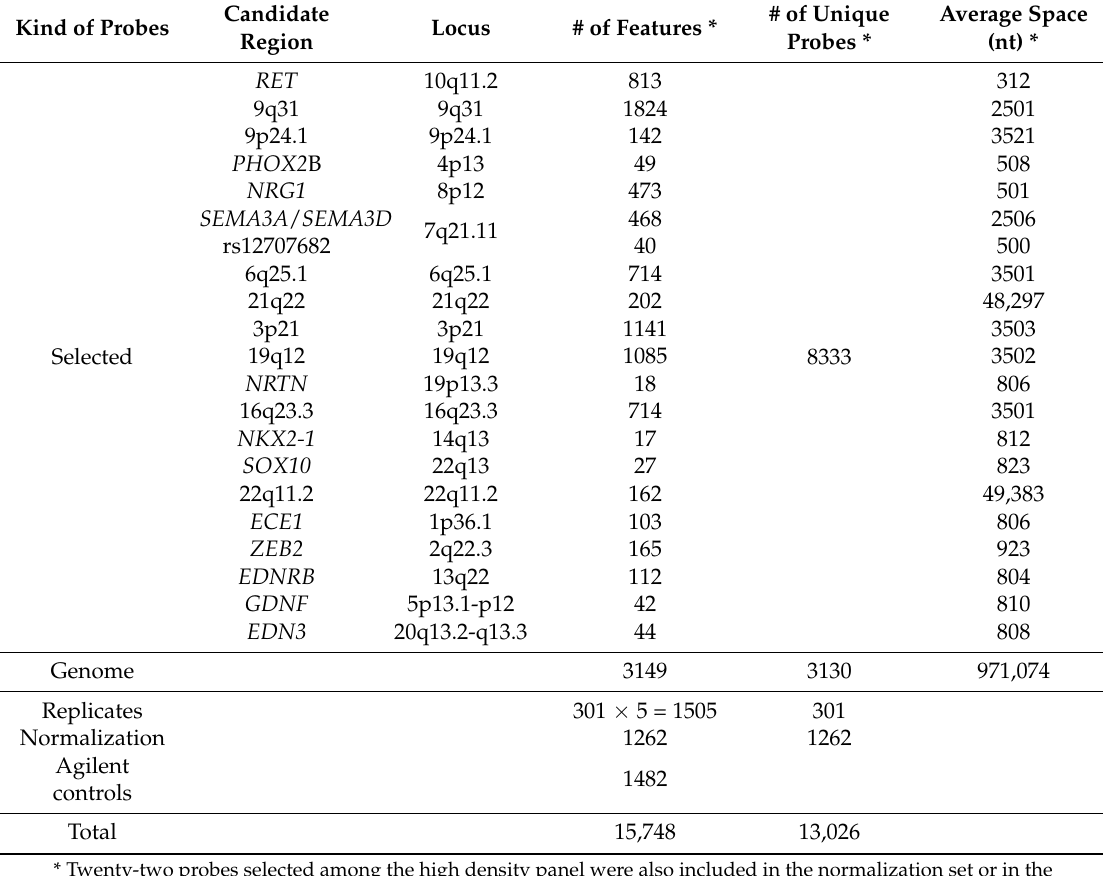
Table 4. Regions mapped on the aCGH and probe